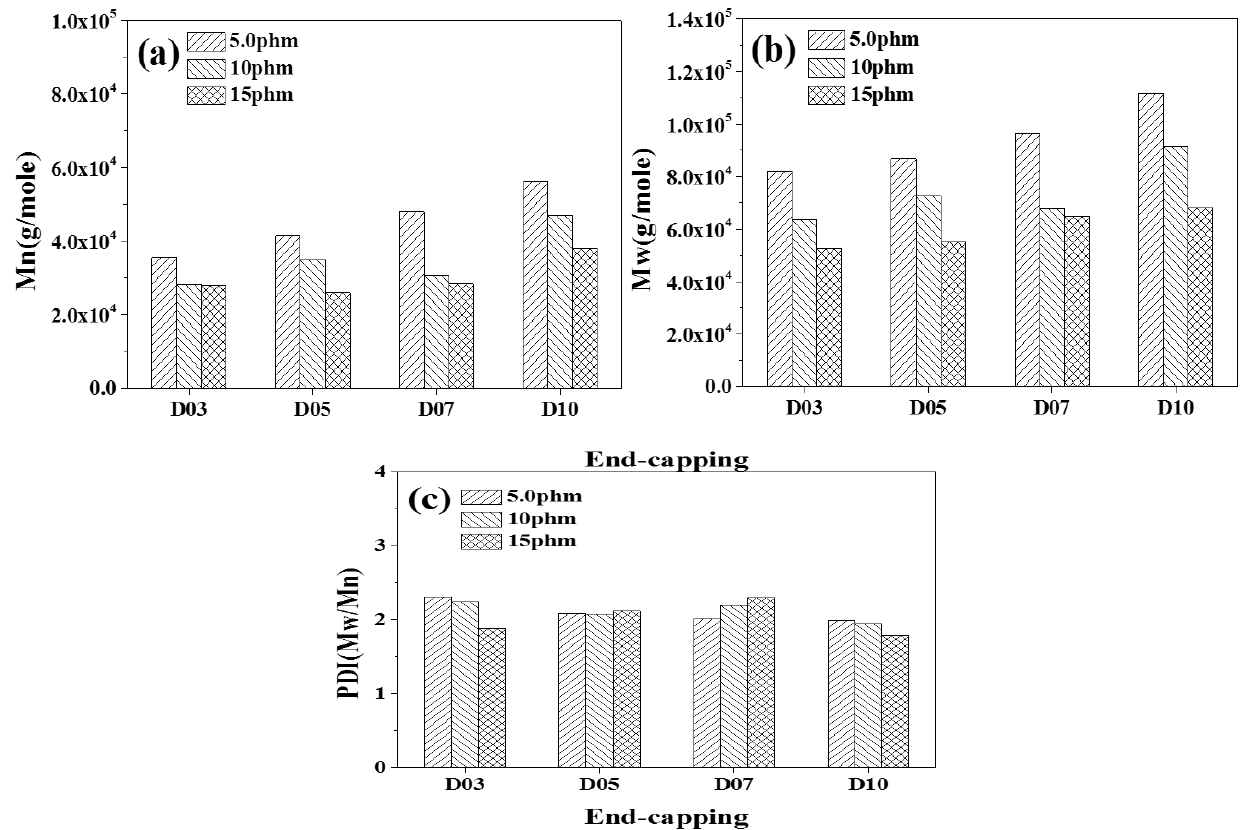
Figure 9. Tendency chart of molecular weight of TPU, ( a ) number average molecular weight (Mn), ( b ) weight average molecular weight (Mw), ( c ) molecular weight distribution coefficient (PDI (Mw/Mn)) of TPU. Table 4. Effect on Mw and Mn of TPU by varying the concentration of DMAA in the end-capping agent and Effect on Mw and Mn of TPU by varying the concentration of end-capping agent.